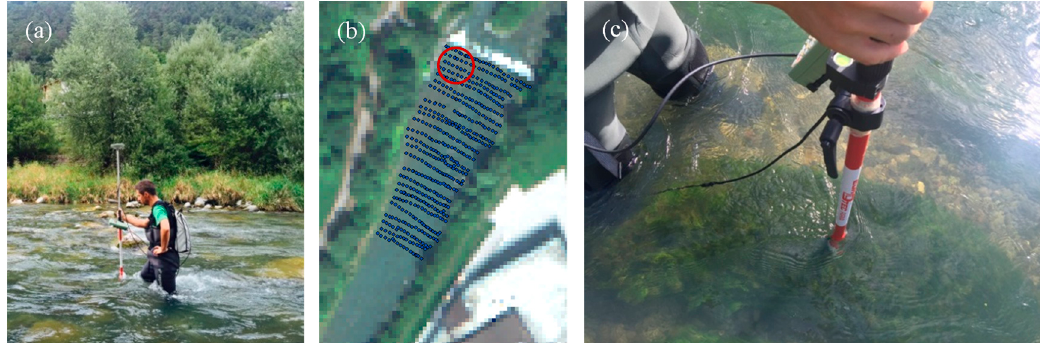
Figure 14. ( a ) Field observations to record water depths and SAV densities assisted by a precise RTK GPS, ( b ) cross-sectional measurement points of water-depths superimposed on the WV3 image, and ( c ) a sample of SAV in the Sarca River. The sampling area used for estimation of K d is highlighted by a circle on the satellite image.